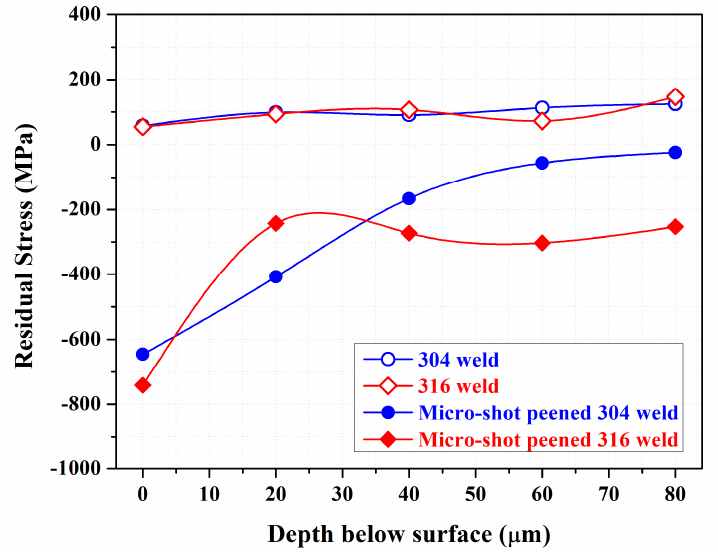
Figure 10. Residual stress distribution of the non-peened and micro-shot peened laser welds determined by XRD.